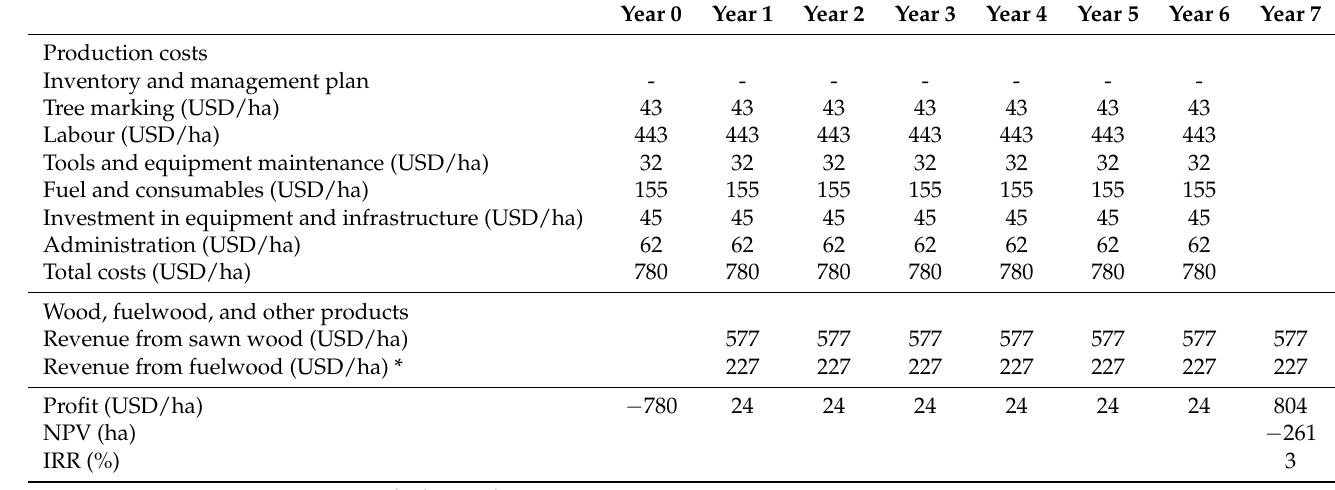
Table 3. Production costs and financial returns from sawn timber and fuelwood with a 7-year cutting cycle in secondary cloud forest. Production costs and income occurred every year since a different area is harvested every year. The volume of wood harvested was 11.7 m 3 ha − 1 and the harvesting intensity applied was 17% of the standing volume (excluding remnant old trees). Amounts in USD are rounded up. NPV = net present value, IRR = internal rate of return (IRR). NPV and IRR are estimated considering a 10% discount rate. Labour includes felling, skidding, cut logging, sawing and loading. Sawn wood includes different prices for multiple species and commercial and secondary products.